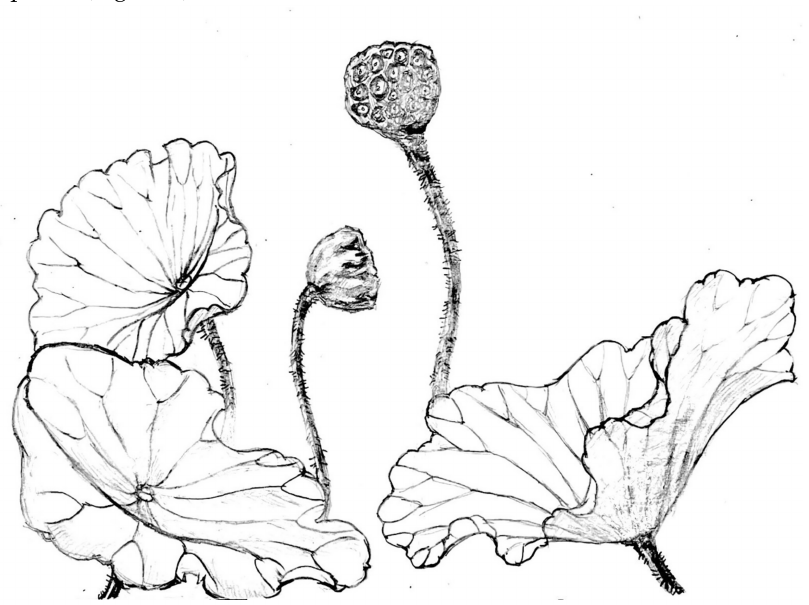
Figure 6. Reconstruction of Nelumbo delinghaensis sp. nov. (drawn by Junjie Wang, one of the authors of this